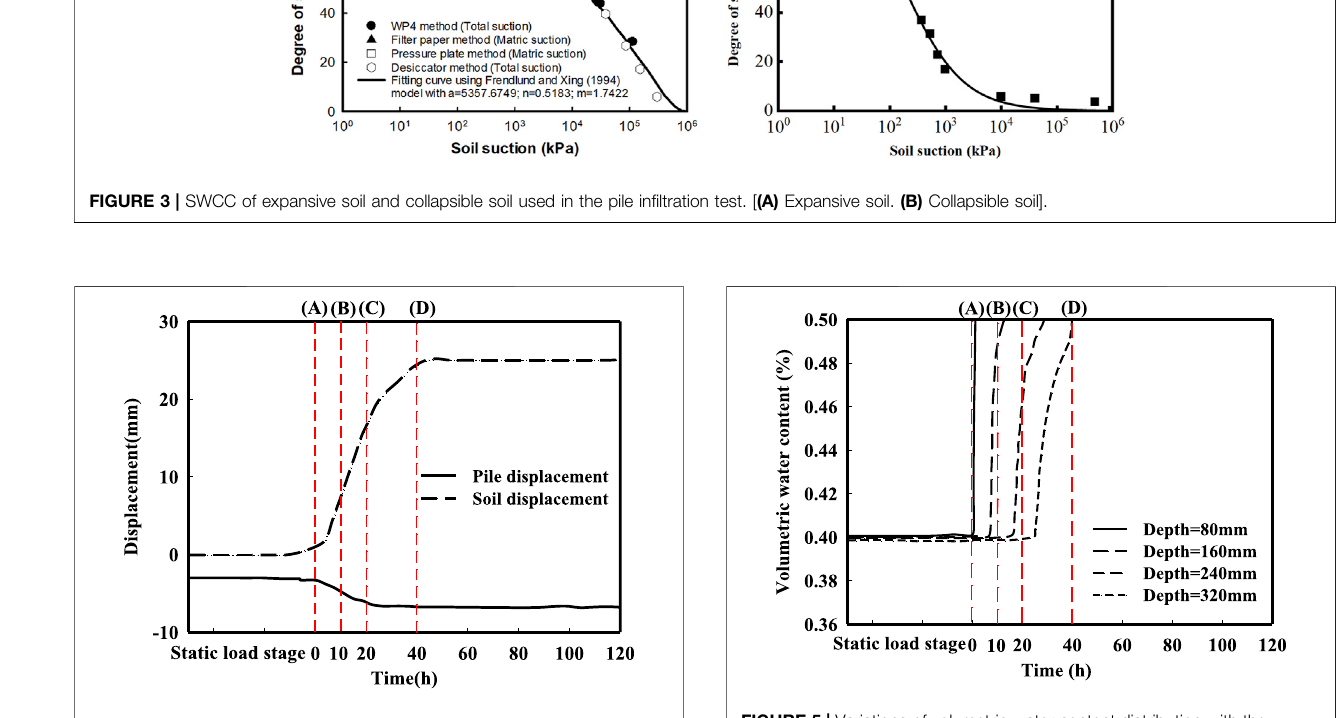
FIGURE4| Variations ofsoiland pileheaddisplacementwiththetimeof PITE.